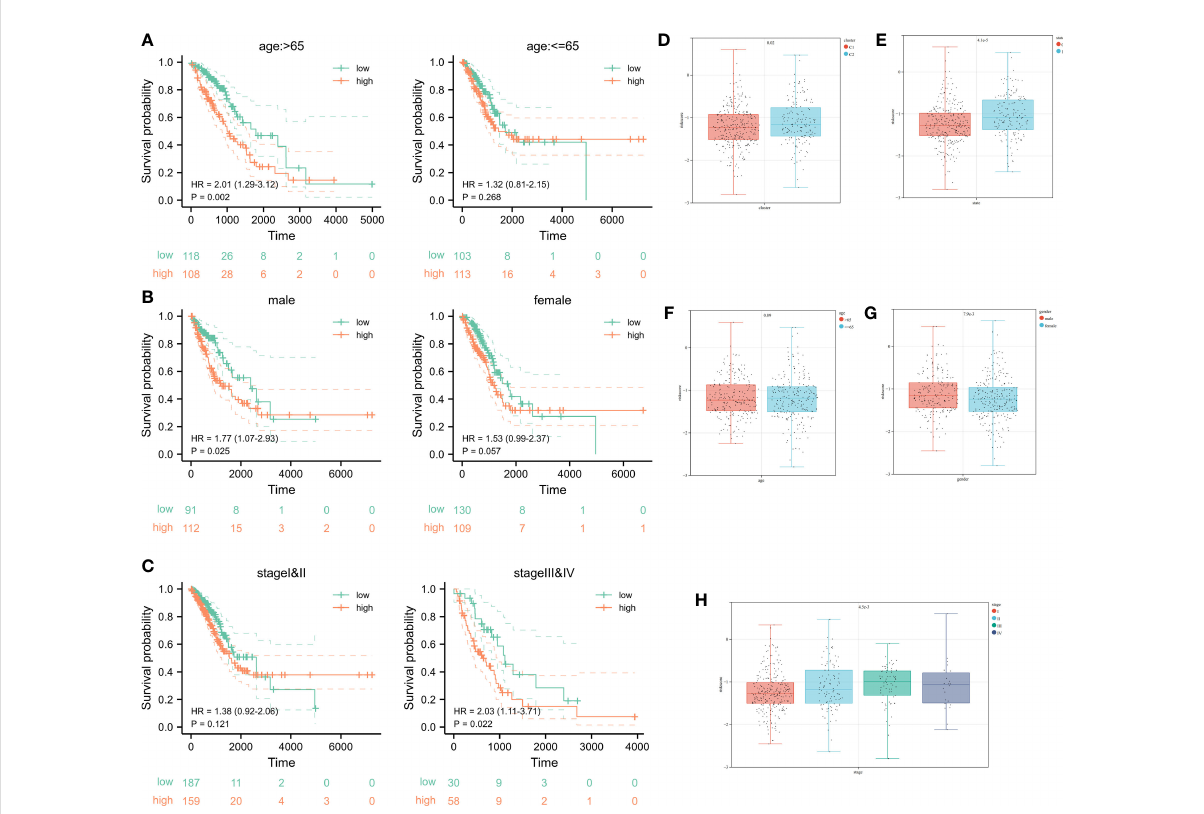
FIGURE 6 Survival analysis after strati fi cation of clinical characteristics and distribution of clinical characteristics after risk strati fi cation. (A-C) Kaplan – Meier curves and the log-rank test showed that the overall survival of the high-risk set was worse than that of the low-risk set in age and gender subgroups of patients. (D-H) The distribution of riskscore in clusters, status, age, gender, as well as pathological